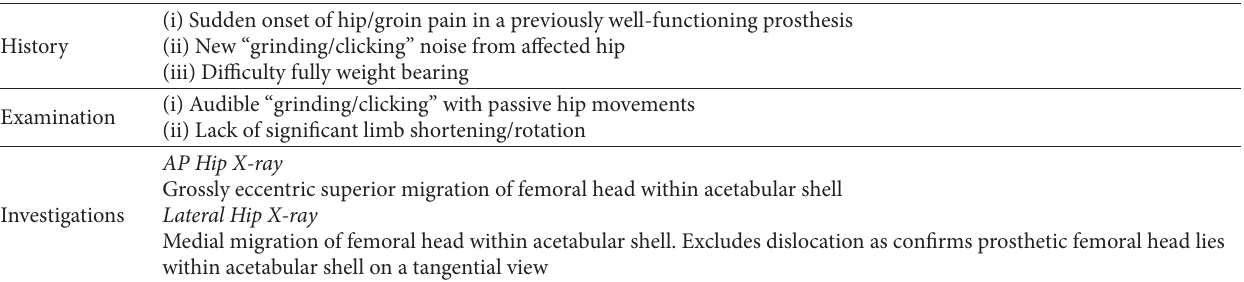
Table 1: Findings suggestive of liner dissociation in the acutely painful